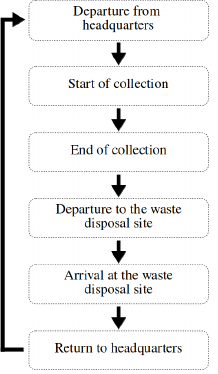
Figure 5. Waste collection service processes identified for itinerary analysis.